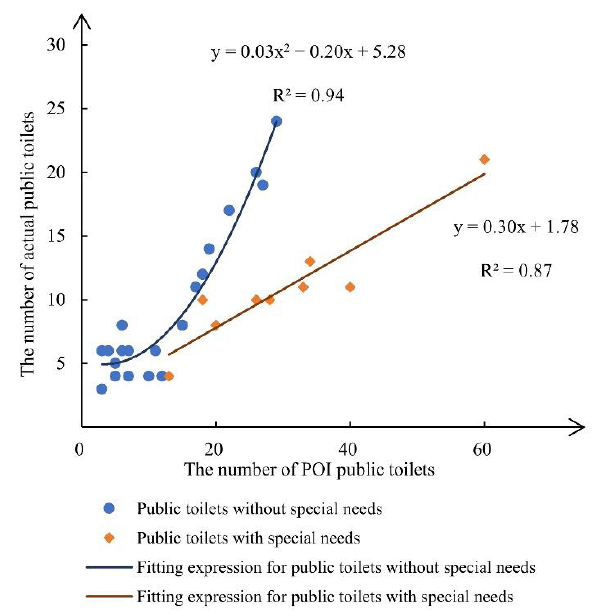
Figure 3. Fitting diagram of POI data and actual survey data.